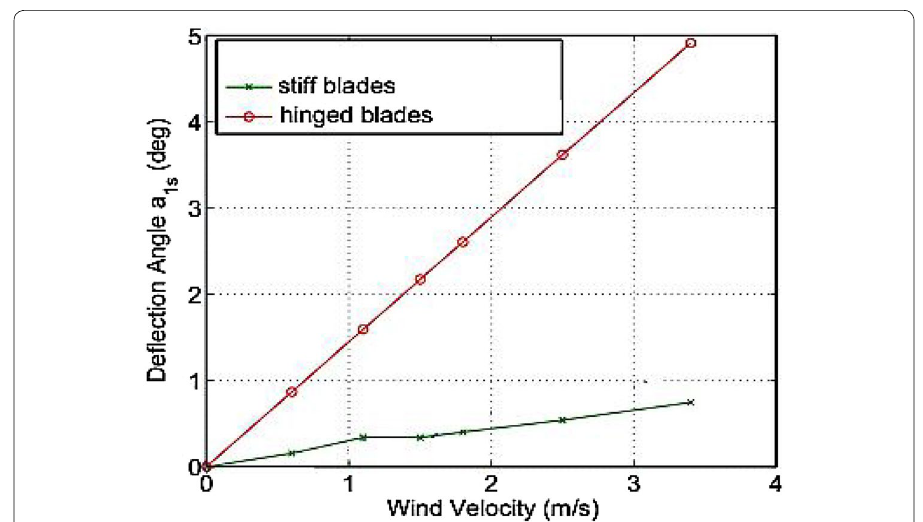
Fig. 9 Graph of the angle of deflection versus the wind